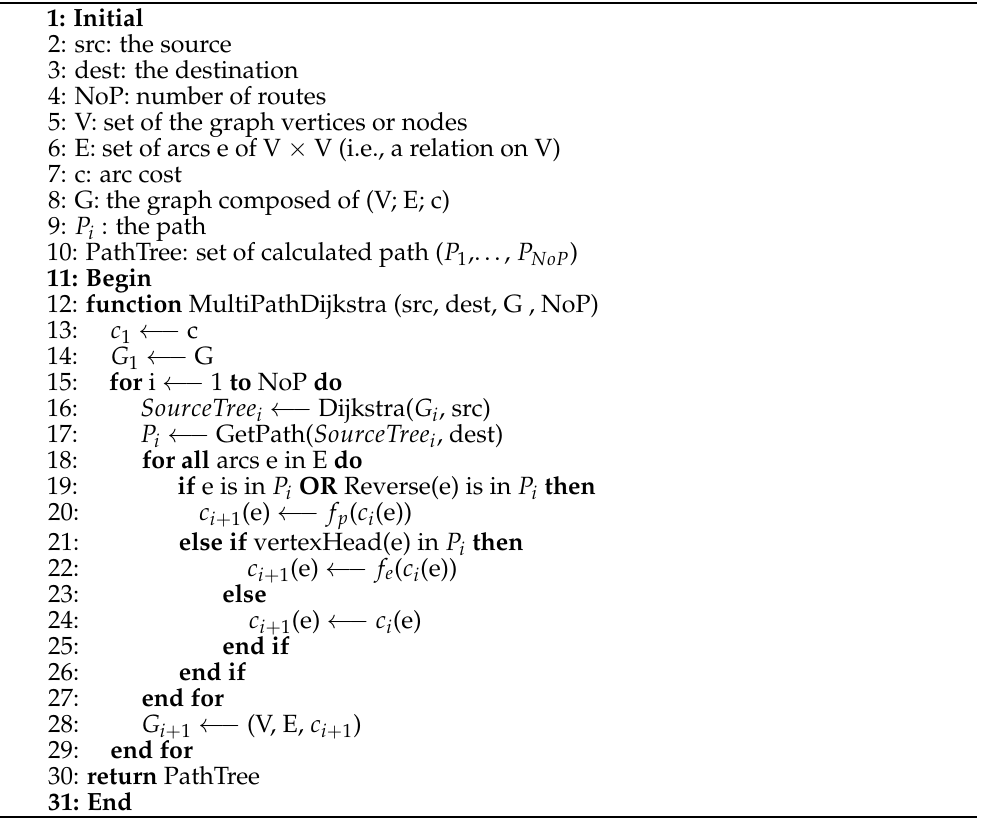
Algorithm 2: Path calculation function